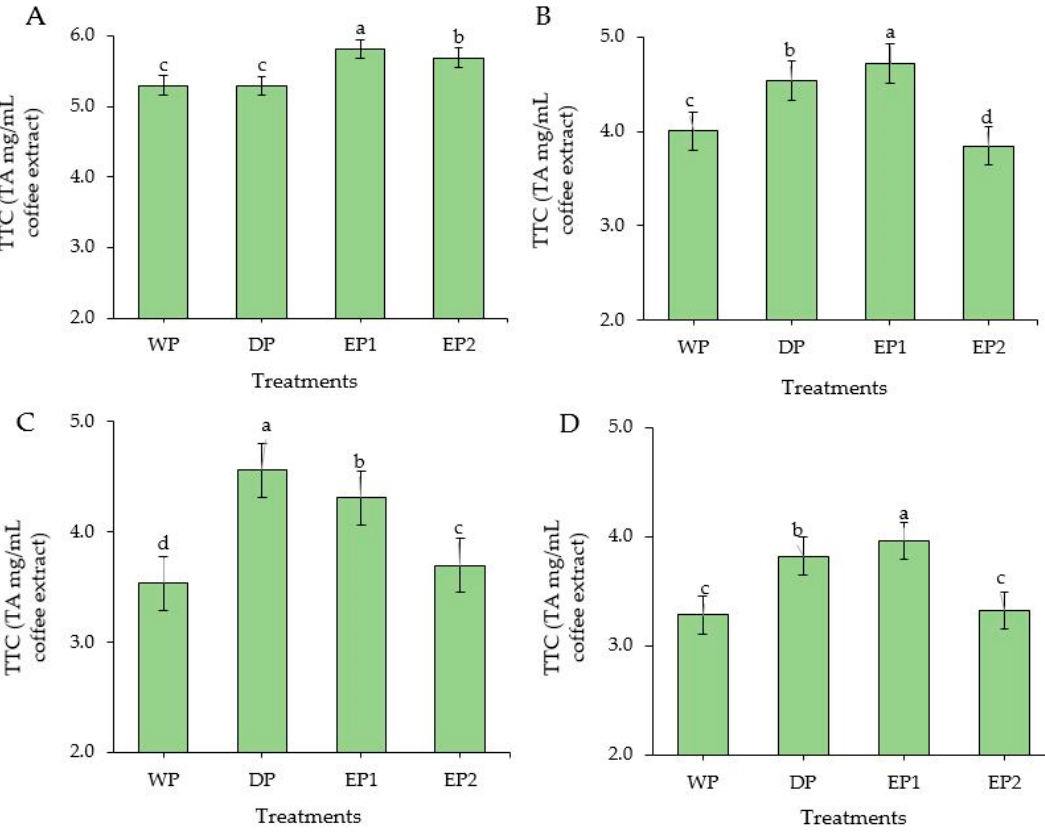
Figure 6. Total tannin content of green and roasted co ff ee beans that obtained using di ff erent processing methods. (( A ): Green beans; ( B ): Light roasted, ( C ): Medium roasted; ( D ): Dark roasted). EP1: elephant dung co ff ee (pulp was completely digested); EP2: elephant dung co ff ee (pulp was not digested); WP: wet-processed beans; DP: dry-processed beans. Di ff erent letters above the bars indicate statistically significant di ff erence at p < 0.05.